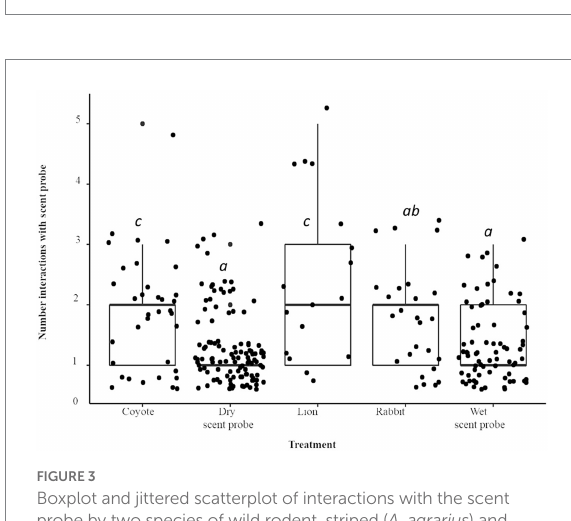
FIGURE 3 Boxplot and jittered scatterplot of interactions with the scent probe by two species of wild rodent, striped ( A. agrarius ) and yellow-necked ( A. flavicollis ) mice. Pairwise comparisons in superscript are significant at the level of p <